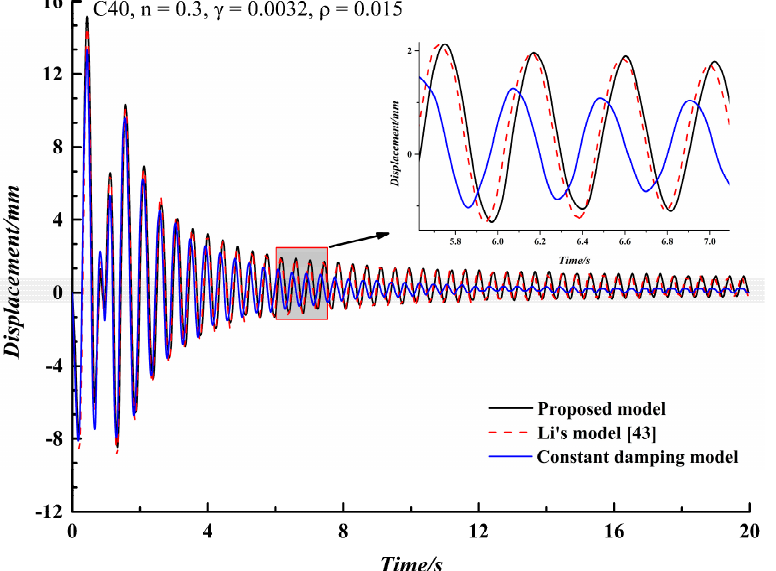
Figure 8. The column head displacement response of FRP-C RC columns with rectangular section under uniaxial harmonic load (C40, n = 0.3, γ = 0.0032, ρ = 0.015).